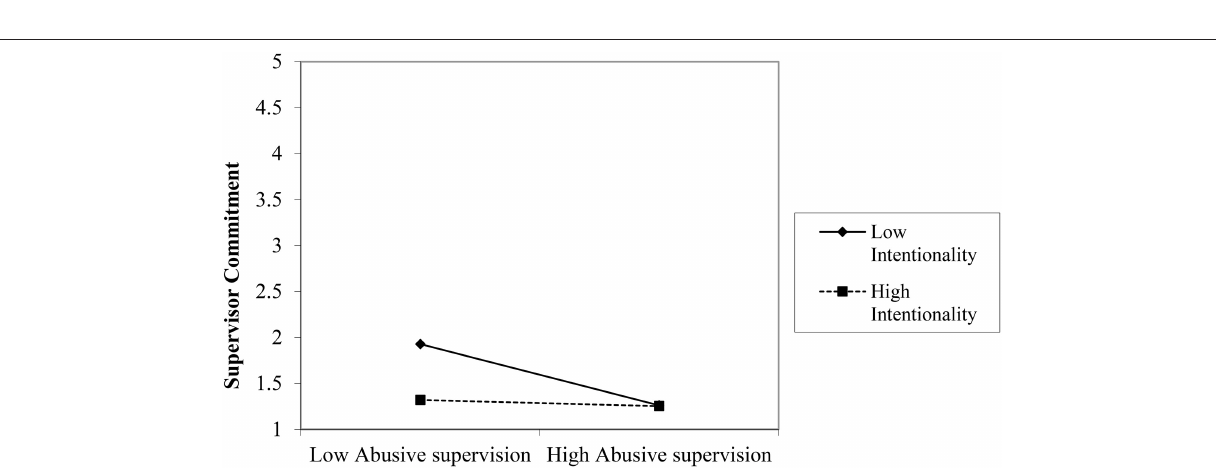
FIGURE 6 | Interaction between abusive supervision and attribution to the supervisor on supervisor commitment (Study 2).